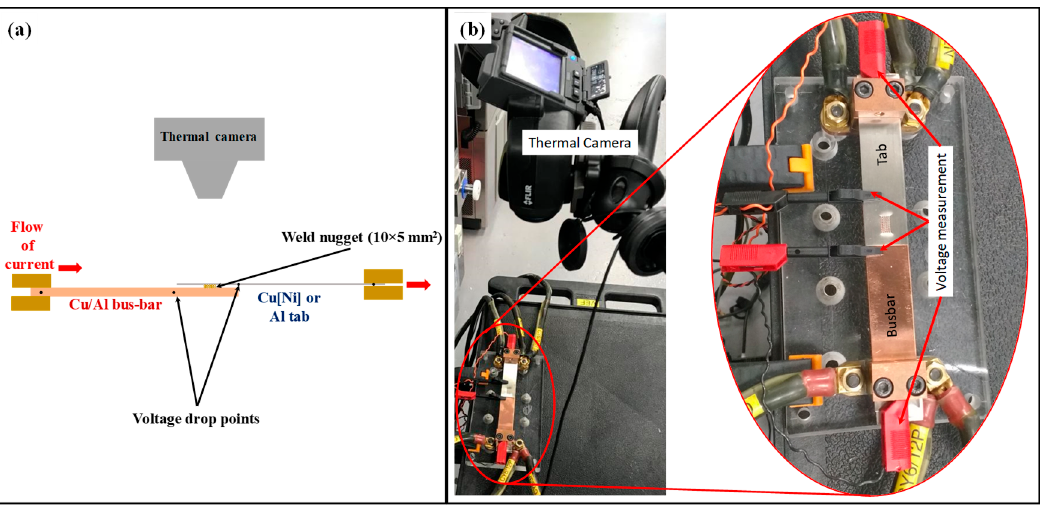
Figure 2. Test set-up for electrical and thermal characterisation of tab-to-busbar joints ( a ) schematic view; and ( b ) experimental set-up. view; and ( b ) experimental